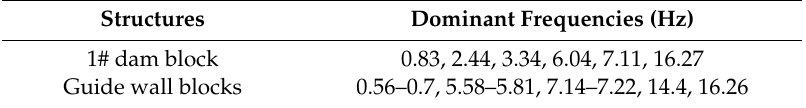
Table 1. Dominant frequencies of horizontal displacements in di ff erent parts of